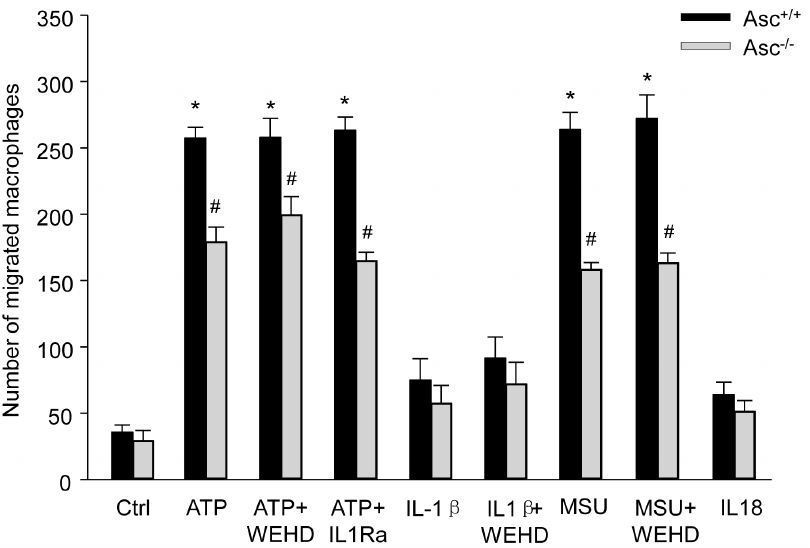
Figure 8. Effect of inflammasome activation on macrophage migration invitro . Macrophage migration in vitro was assayed using Transwell inserts with a 5 m m porous membrane. The migratory cells on the lower side of insert membrane were quantified. BMMs in Transwell inserts were primed with LPS (1 ng/ml) for 3 h and treated with ATP (2.5 mM, 16 h), IL1 b (0.5 ng/ml), MSU (100 m g/ml), or IL18 (25 nM) in the absence or presence of caspase-1 inhibitor WEHD (0.15 m g/ml) or IL1R antagonist (IL1Ra, 40 ng/ml). Quantification of the transwell assays reveals the ability of BMMs to migrate from inside Transwell inserts through the membrane upon stimulation. * P , 0.05 vs . untreated Asc + / + control group; # P , 0.05 Asc 2 / 2 vs. Asc + / + group (n=6).